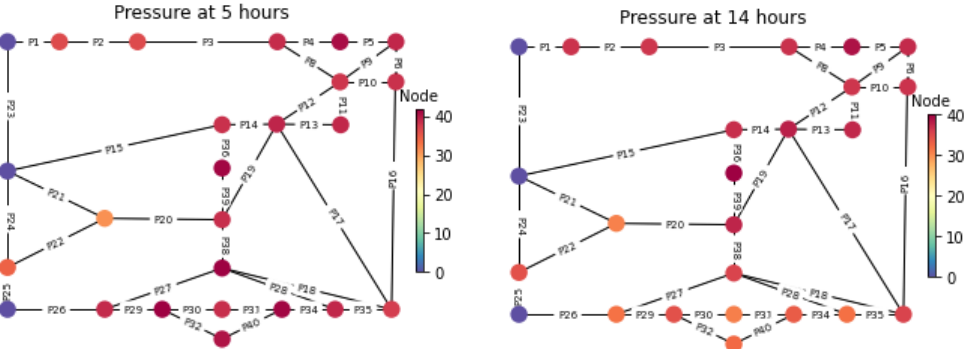
Figure 6. Pressure data for the 5 am and 2 pm.